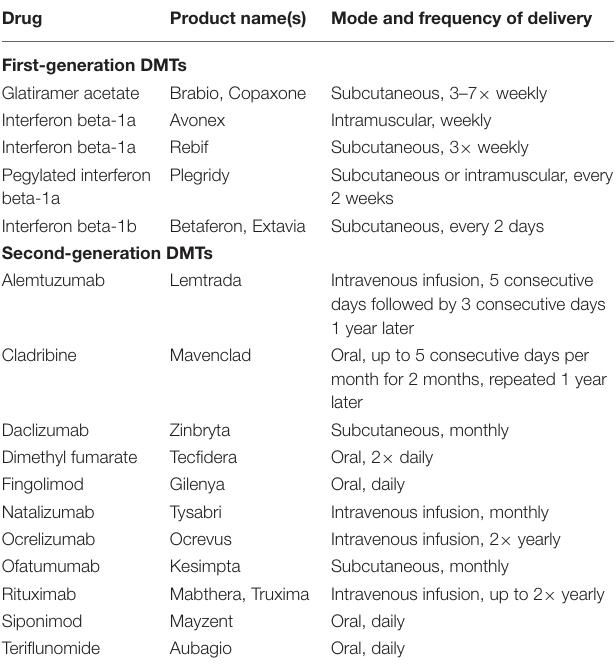
TABLE 1 | Classification of DMTs in the Optimise:MS